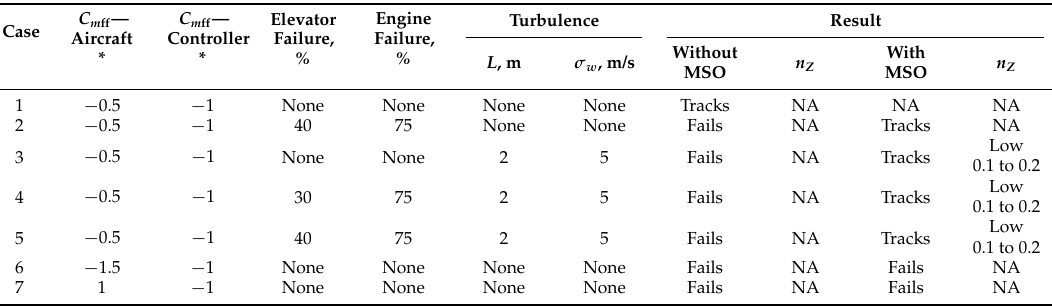
Table 4. Simulation results—modeling error in an